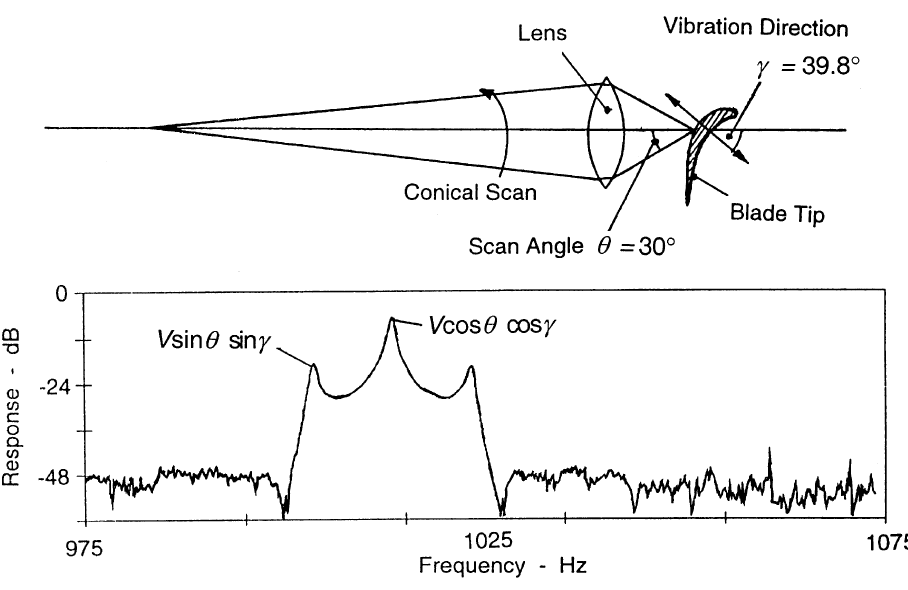
Fig. 8. Measurement of vibration direction using a conical